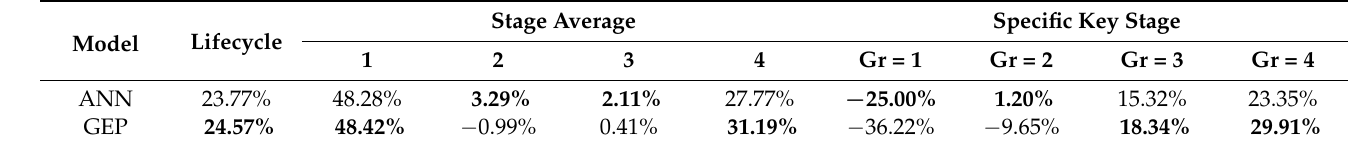
Table 4. RMSE comparison between AI-based ANN, GEP models to the REG